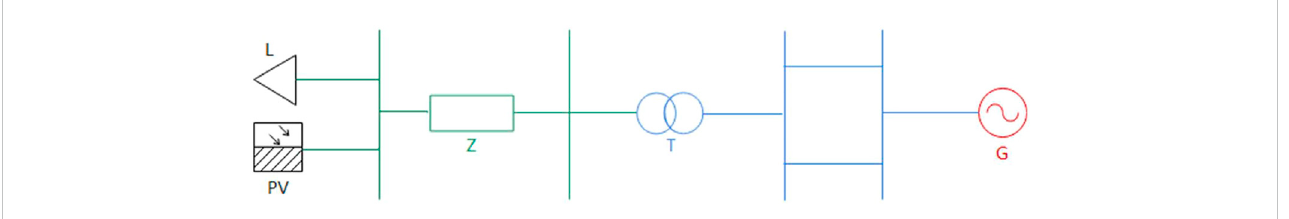
FIGURE 1 Equivalent structure of distribution